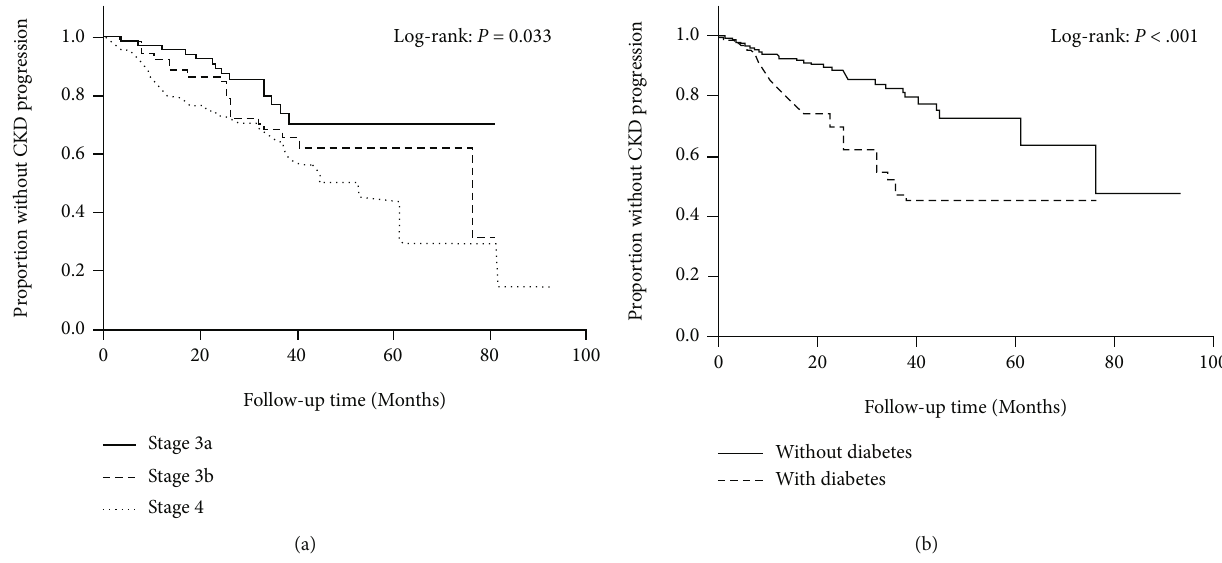
Figure 1: The Kaplan-Meier survival plot of CKD progression by CKD stages (a) and diabetic status